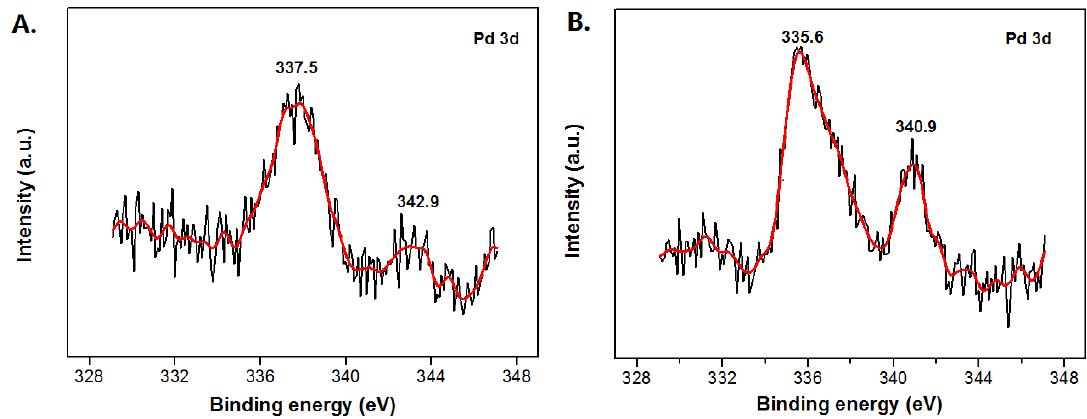
Figure 2. XPS spectra of the Pd 2+ @MMT/PEO ( A ) and Pd 0 @MMT/PEO ( B ) catalytic composites.